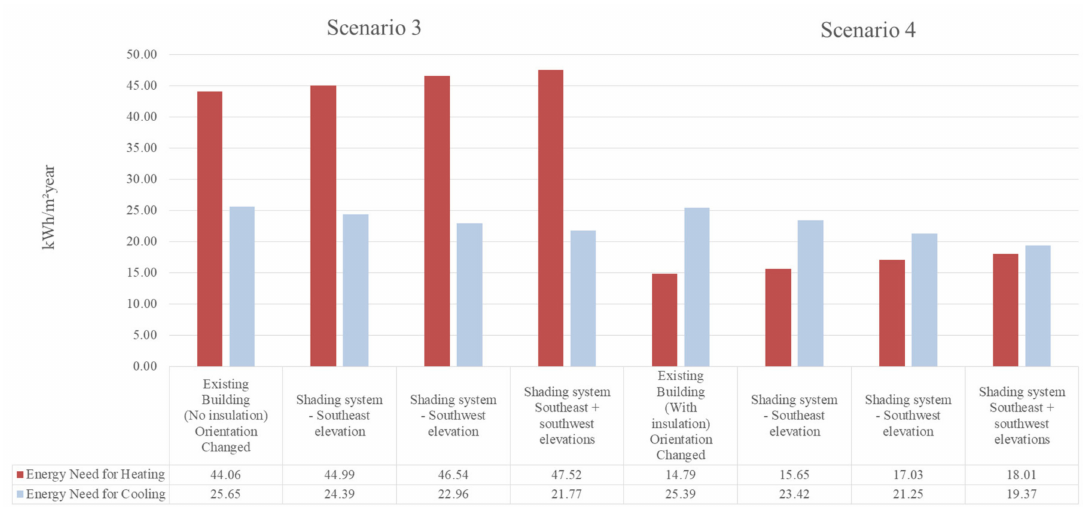
Figure 9. Calculation of the energy need (kWh/m 2 year) and Energy Certification with HULC—scenarios 3 and